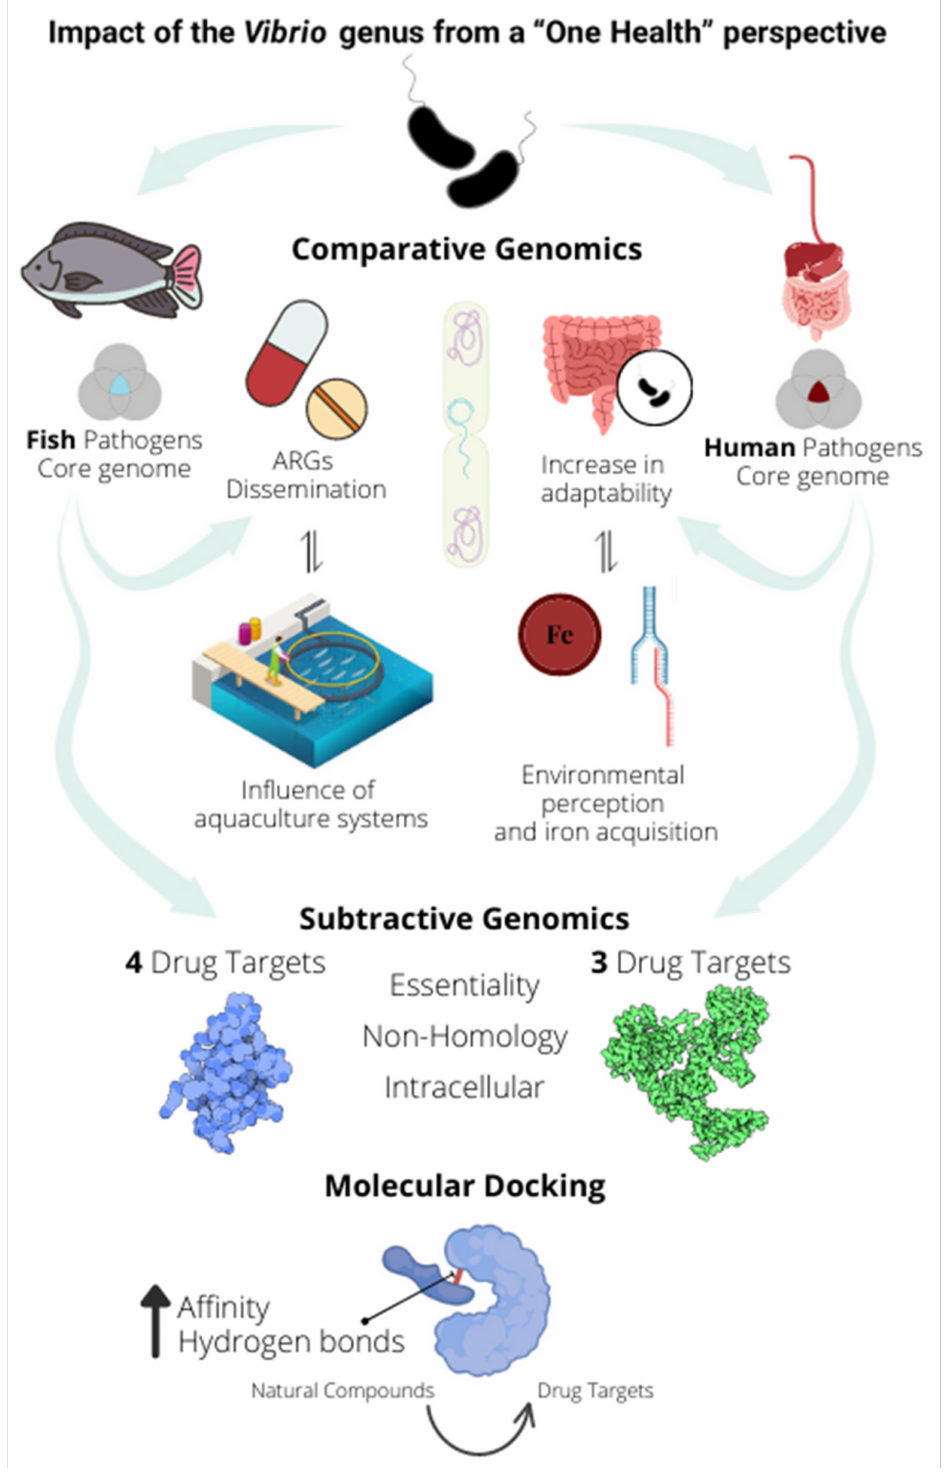
Figure 8. Graphical conclusion. Genomes of fish and human pathogens were used for core genome identification, and comparative analyses demonstrated the ability of pathogens to adapt to the human host linked to horizontal gene transfer and iron uptake, and the impact of selective pressure of aquaculture on the dissemination of resistance genes. Finally, a pipeline of subtractive genomics and molecular docking was performed to identify potential natural compounds capable of inhibiting the active site of the identified drug